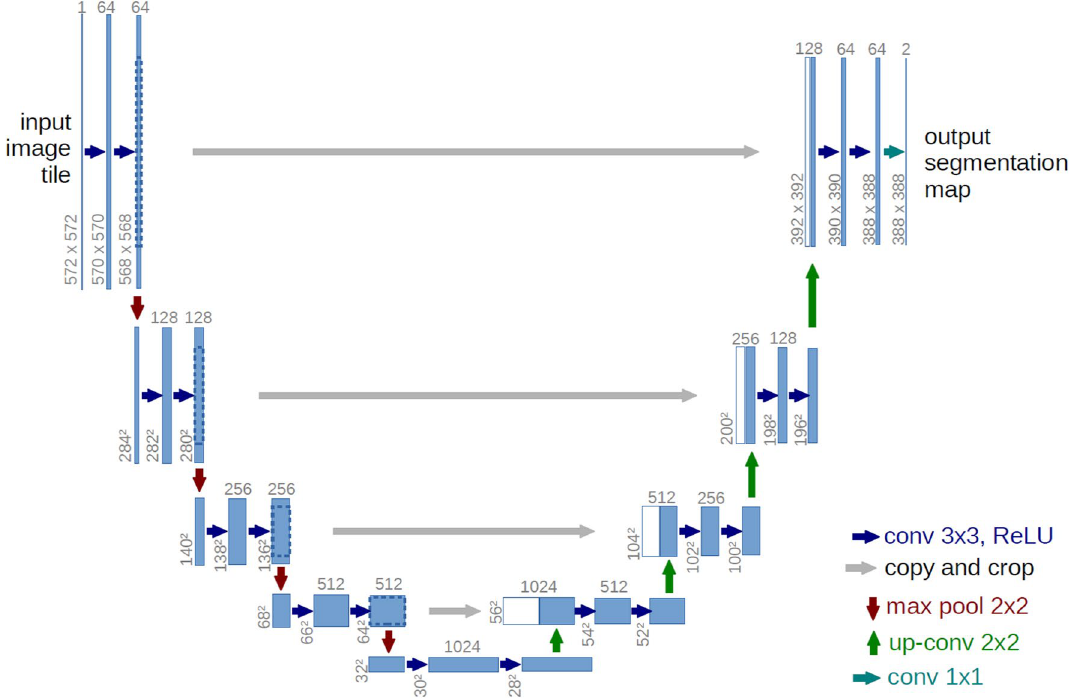
Fig. 1 The architecture of UNet